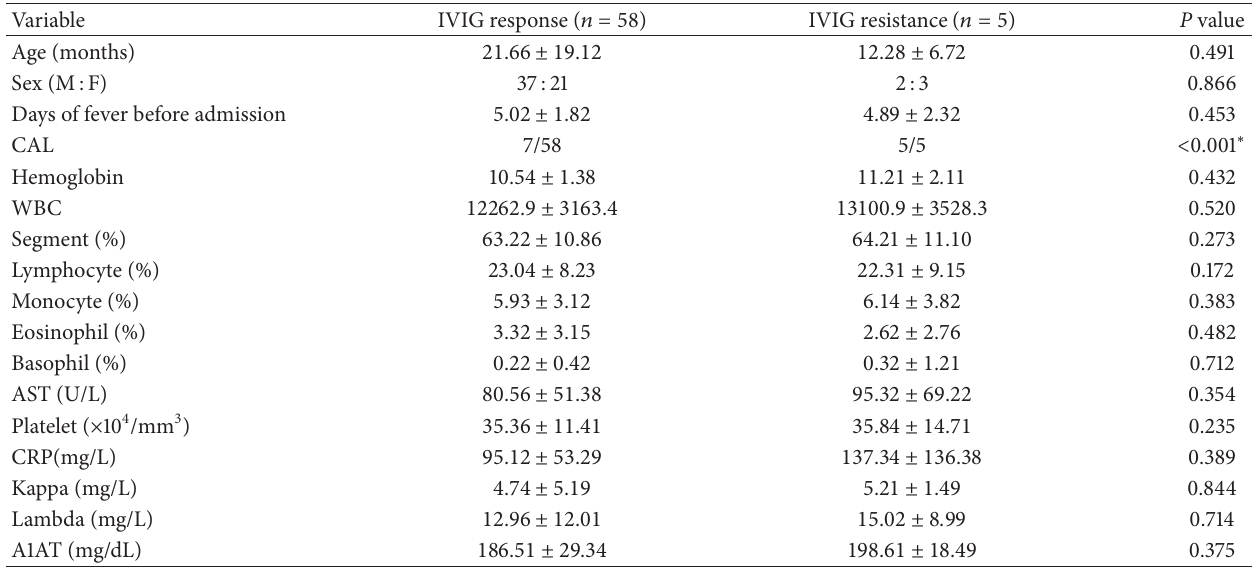
Table 2: Demographic and clinical characteristics of patients with Kawasaki disease who had a response to IVIG or were IVIG resistant. Variable